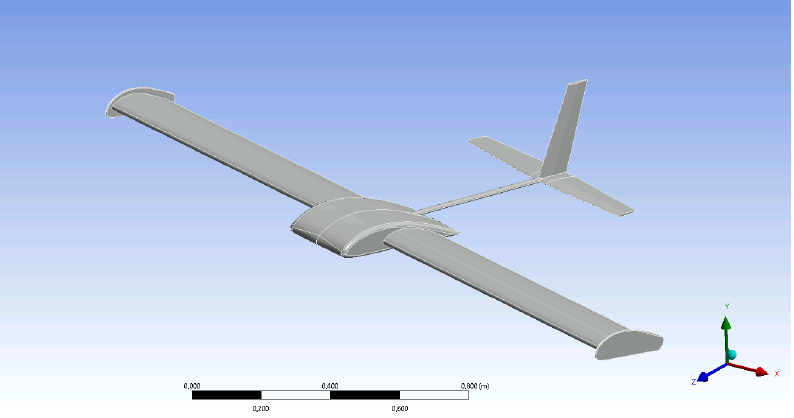
Figure 4. Meshing tool screenshot from Ansys featuring the simplified 3D model and Ansys de- fault